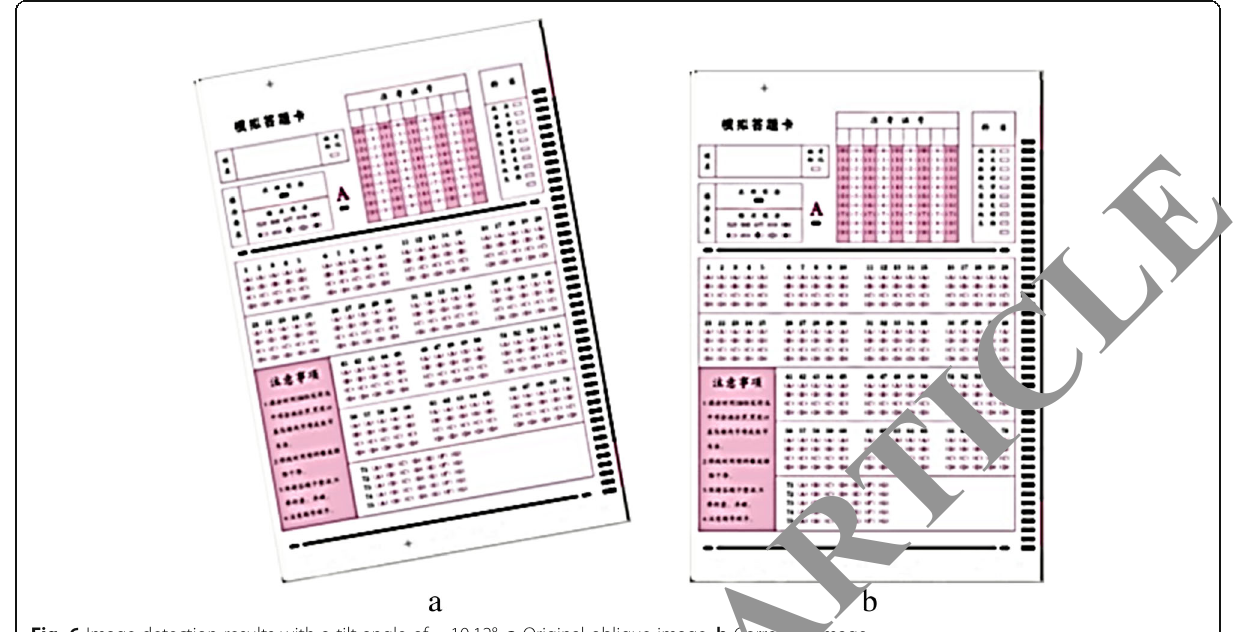
Table 1 Comparison of various parameters of image correction Image Parameter Traditional